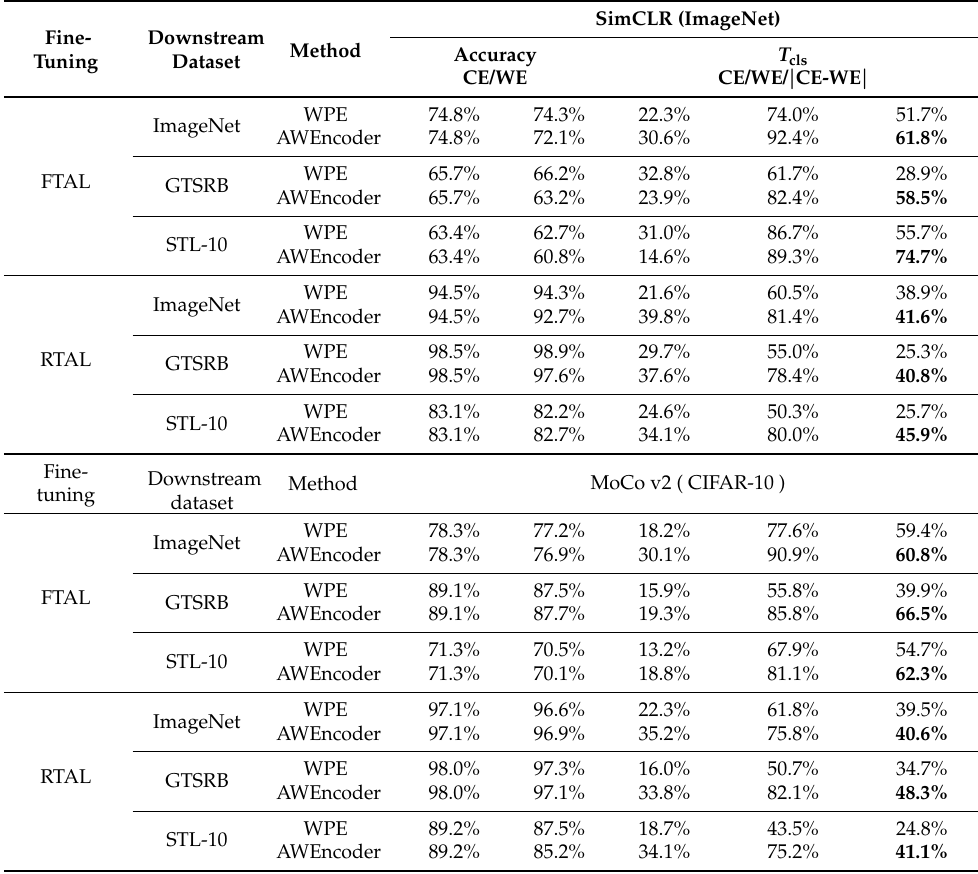
Table 8. Robustness in black-box verification against